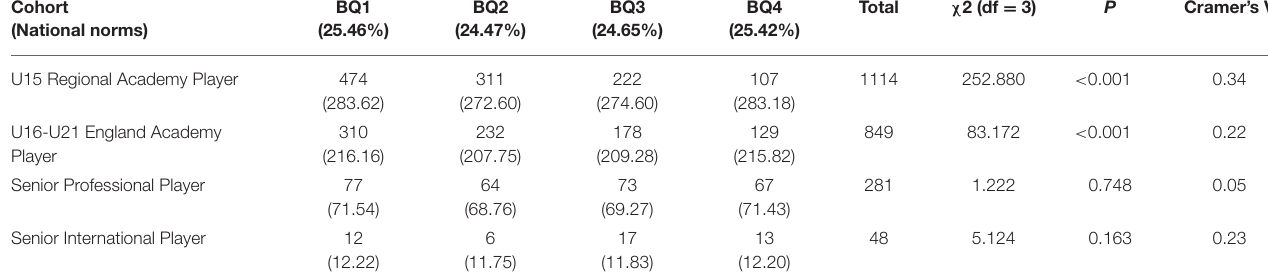
TABLE 1 | The BQ distributions of the professional and international pathways. Cohort (National norms)